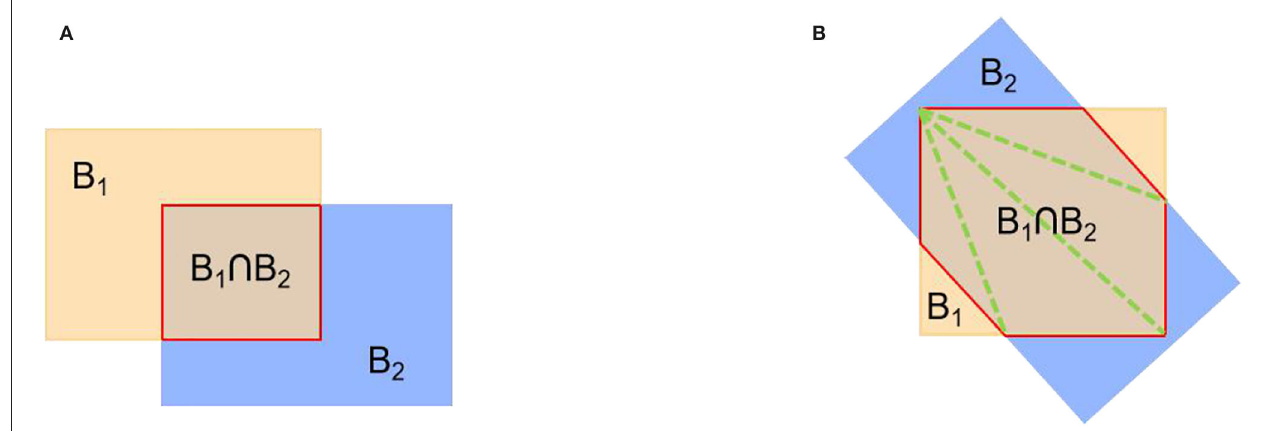
FIGURE 11 | Examples of standard IoU and S-IoU computation. (A) Standard IoU and (B) S-IoU.